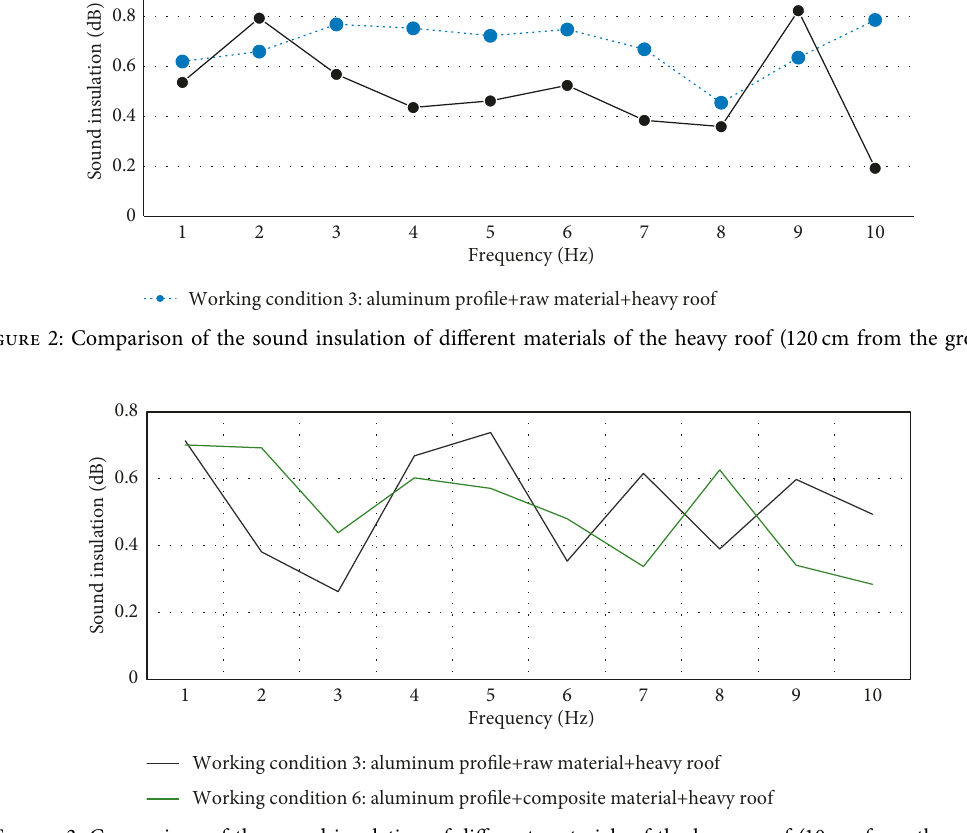
Figure 3: Comparison of the sound insulation of different materials of the heavy roof (10cm from the